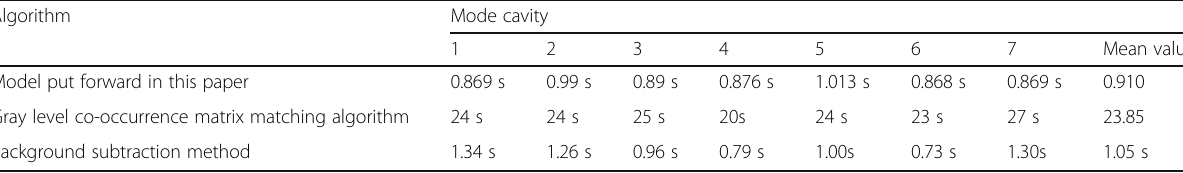
Table 2 Time consumption for the detection of residues in the mold cavity Algorithm